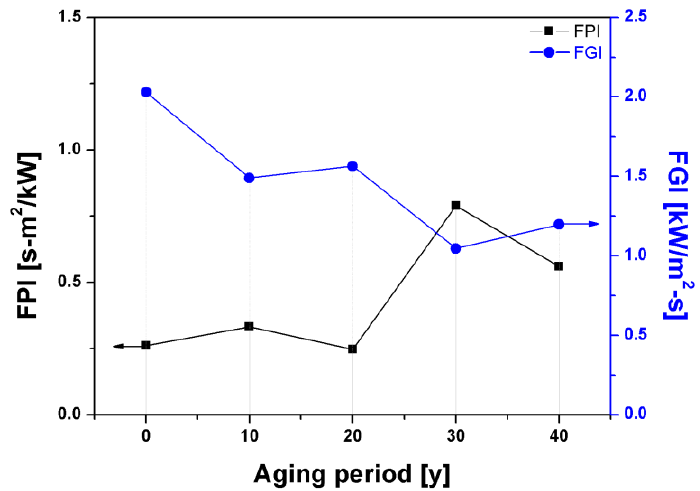
Figure 5. Fire performance index (FPI) and fire growth index (FGI) with respect to the accelerated aging periods. aging